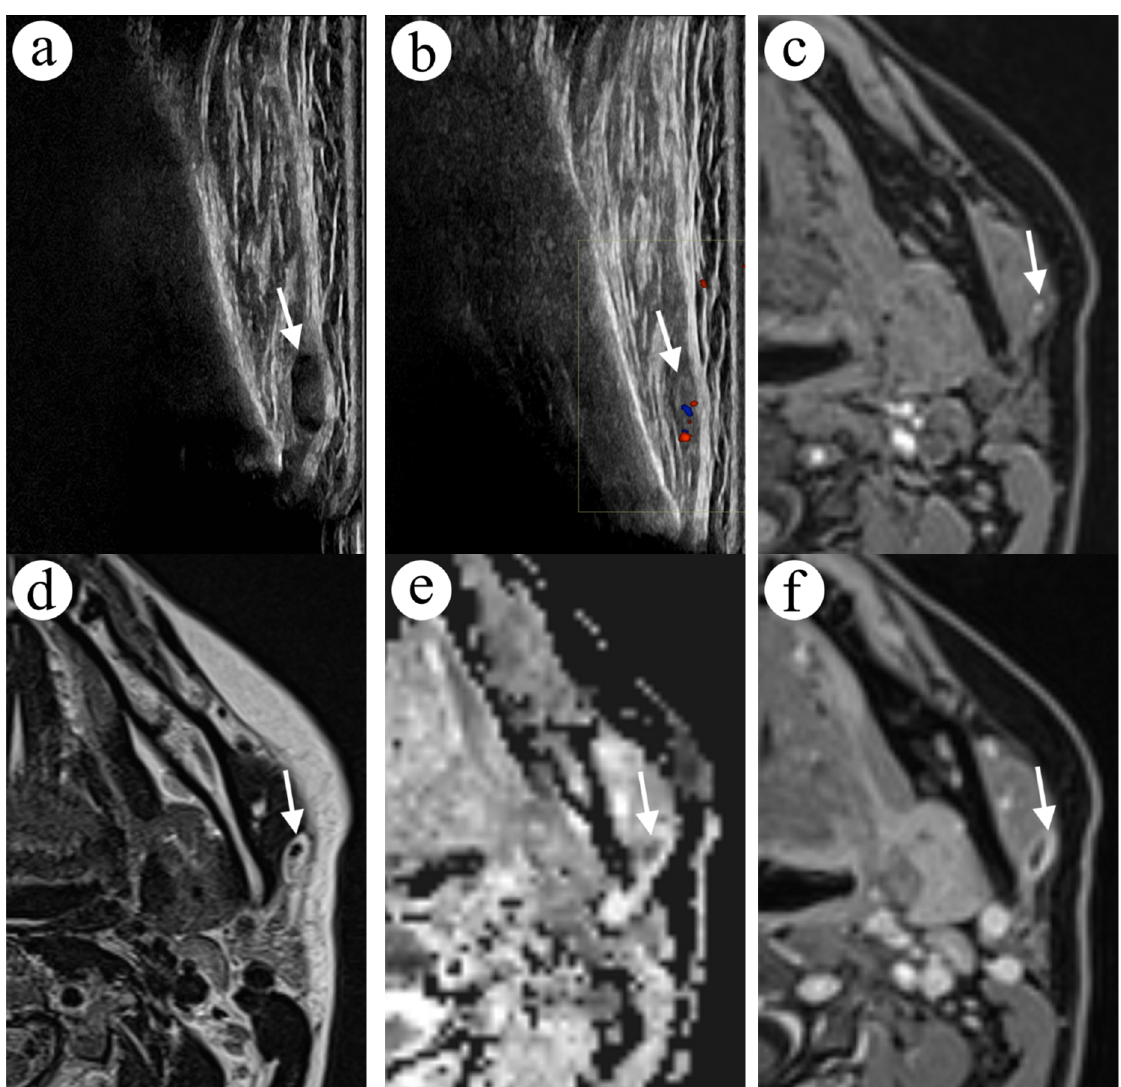
Figure 4. A focal lesion in the left parotid region, adjacent to the posterior border of the masseter muscle US image, rotated 90 degrees to match the anatomy in MR images. In the first US examination, the lesion presented as hypoechoic (arrow, a ) and changed to hyperechoic in the second US examination (arrow, b ). In the fat-saturated gradient echo sequence (VIBE Dixon) in the axial T1-weighted image ( c ), the lesion was hypointense with a hyperintense focus in the centre (arrow). In the turbo spin echo sequence in the axial T2-weighted image ( d ), the lesion had a hypointense focus in the centre (arrow). The lesion restricted diffusion in DWI ( e ) and showed peripheral enhancement (arrow) in the fat-saturated gradient echo sequence (VIBE Dixon) in the axial T1-weighted image ( f ).